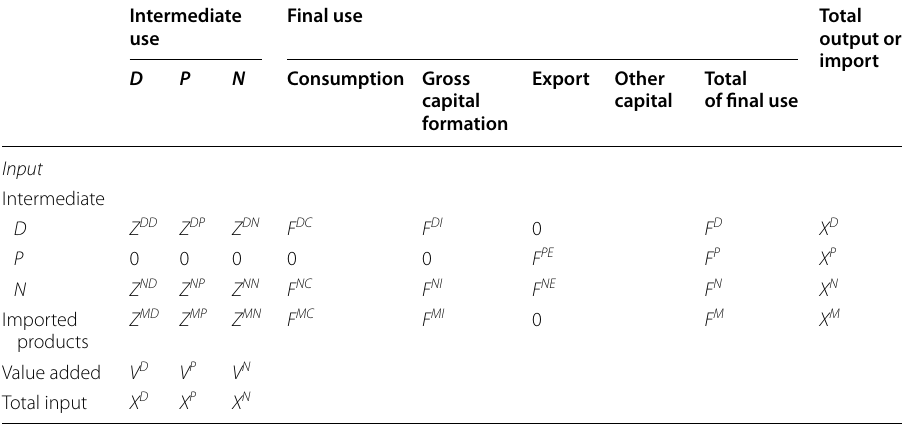
Table 1 Non-competitive input-occupancy output table for capturing processing trade ( DPN table)